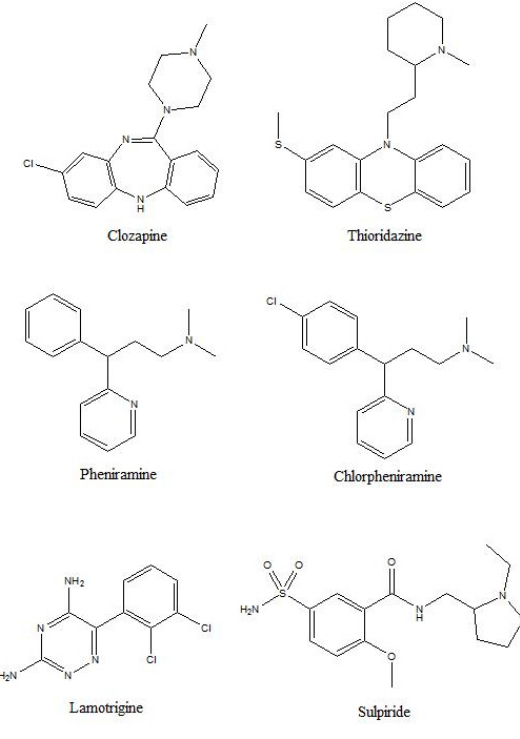
Figure 1. Chemical structures of the analyzed psychotropic